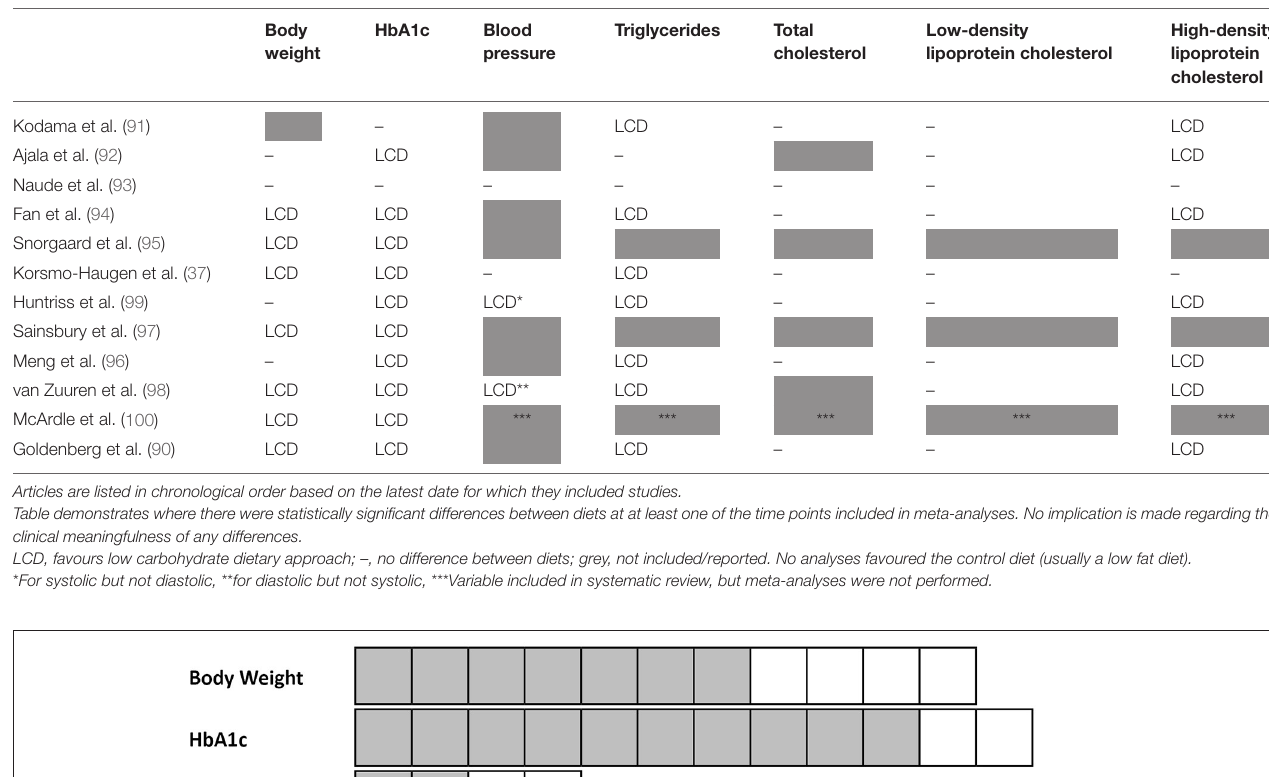
TABLE 1 | Summary of significant differences in meta-analyses assessing low carbohydrate dietary approaches for the management of Type 2 diabetes.